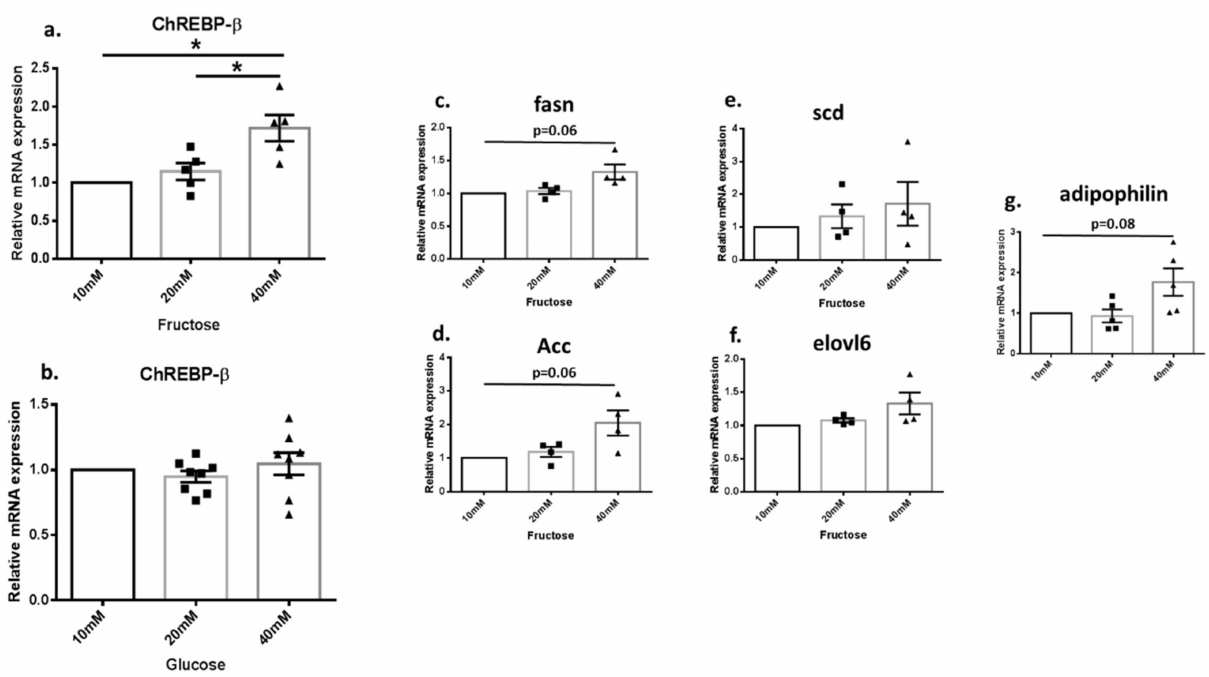
Figure 4. Fructose but not glucose upregulates ChREBP β expression in the human kidney cell line HK2. HK2 cells have been treated with fructose ( a ) or glucose ( b ), at 10, 20 and 40 mM, and ChREBP β expression level, were measured. Fructose-treated cells were also screened for the DNL ChREBP β downstream genes— Fasn ( c ), Acc ( d ), Scd ( e ), Elovl6 ( f ) and adipophilin ( g ). * p ≤ 0.05. The results represent 4–8